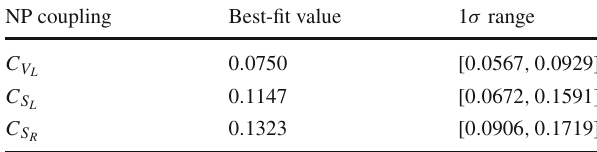
Table 5 Best-fit values of the NP